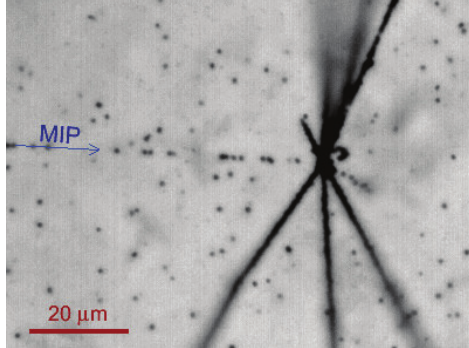
Figure 3. Microscopic view of the emulsion films with several types of tracks (from [21]). The thicker the tracks, the higher is their energy